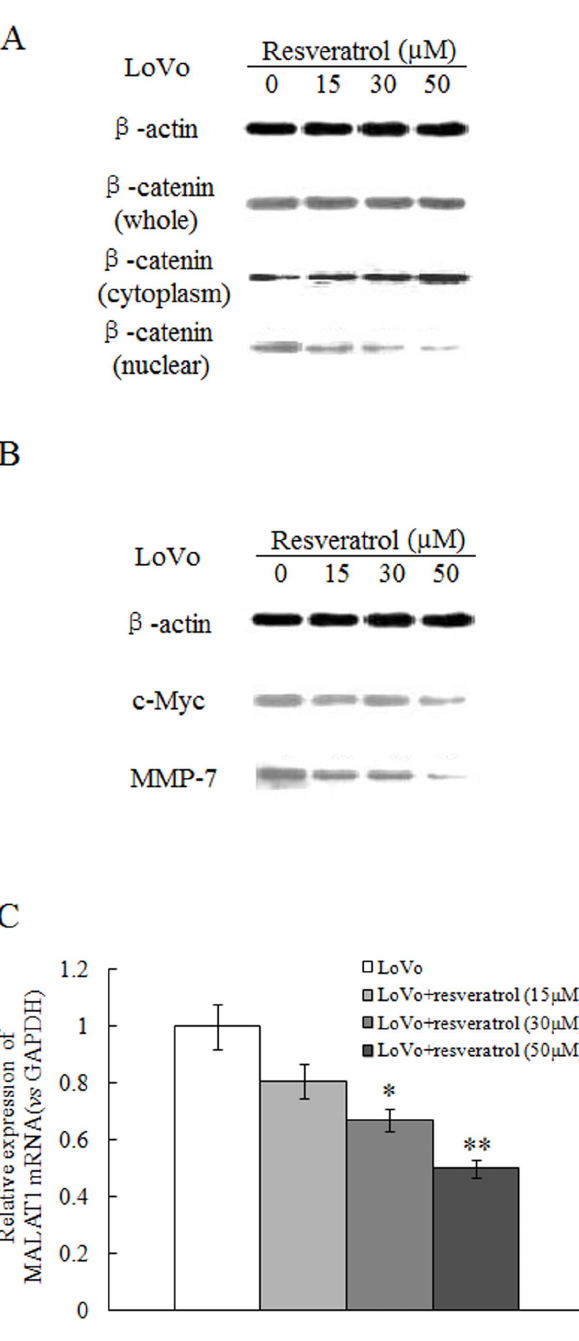
Figure 3. Resveratrol decreases the nuclear localization of b -catenin, levels of its downstream proteins, and represses MALAT1 expression in LoVo cells. (A): Total or cell extracts of different cellular compartments from LoVo cells treated with resveratrol were probed for b - catenin. b -catenin protein levels were quantified. * p , 0.05 or ** p , 0.01, compared with control group. (B): Total cell extracts of LoVo cells treated with resveratrol were probed for c-Myc, MMP-7 and the protein levels were quantified. * p , 0.05 or ** p , 0.01, compared with control LoVo cells. (C): The expression levels of MALAT1 from LoVo cells treated with indicated doses of resveratrol were determined by real time PCR. The relative MALAT1 promoter activities in LoVo cells treated with indicated resveratrol doses were measured. * p , 0.05 or ** p , 0.01, compared with control LoVo cells. with ice-cold phosphate buffered saline (PBS), lysed by RIP lysis together with rotating for overnight at 4 u C. Afterwards, proteins in buffer. Both b -catenin (CST, USA) and nonspecific control rabbit the immunoprecipitate were digested with proteinase K and IgG antibodies were used for the immunoprecipitation. RIP lysates bound RNAs were purified from the supernatants, reverse- and magnetic beads-bound b -catenin antibody were incubated